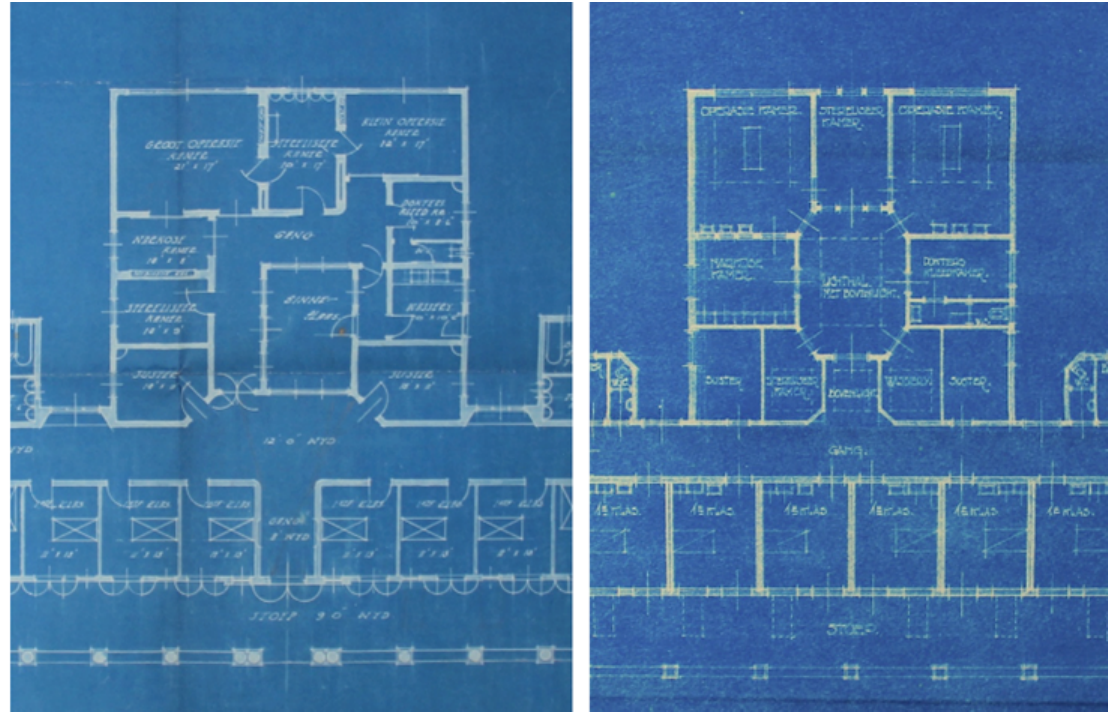
Figure 3. Johan R. Burg’s plan of an operating theatre wing for the Zuid Afrikaans Hospital (left), improved by Johan Hanrath (right). Translation: Operasie kamer: Operations Theatre; Narkose kamer : Anaesthetics room; Binne-plein : Courtyard; Lichthal met bovenlicht : Light well with